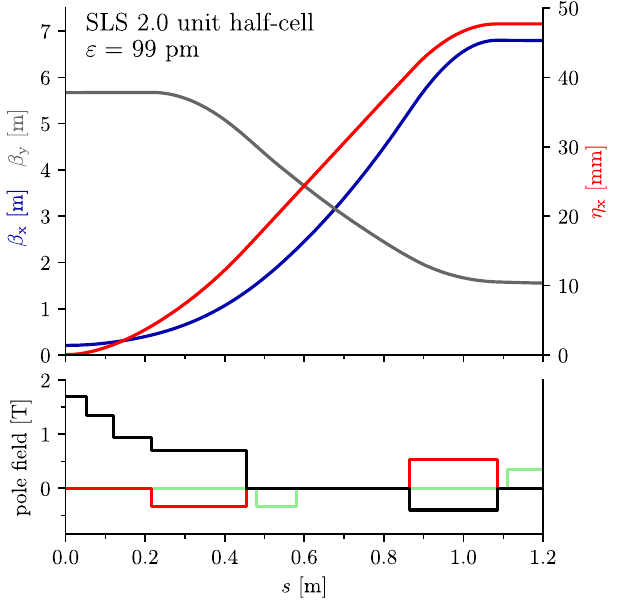
FIG. 17. The unit cell of the SLS upgrade lattice “ SLS 2.0 ” represents a fully optimized, real LGB/RB cell (see Fig. 4 for legend).